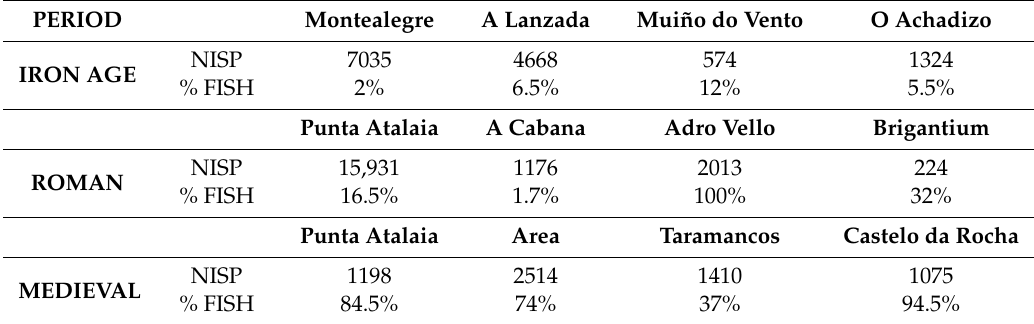
Table 1. Galician coastal middens: contribution through time of fish and shell remains in the largest faunal collections. Mean values of fish remains’ contributions rise from 4% in the Iron Age, to 28% in Roman times and 71% during Medieval times. More data are required to confirm whether this emphasis from mollusk to fish reflects a real change in the economy or taphonomical constraints having to do with fish bones being less robust than shells (unpublished data). PERIOD Montealegre A Lanzada Muiño do Vento O Achadizo IRON AGE